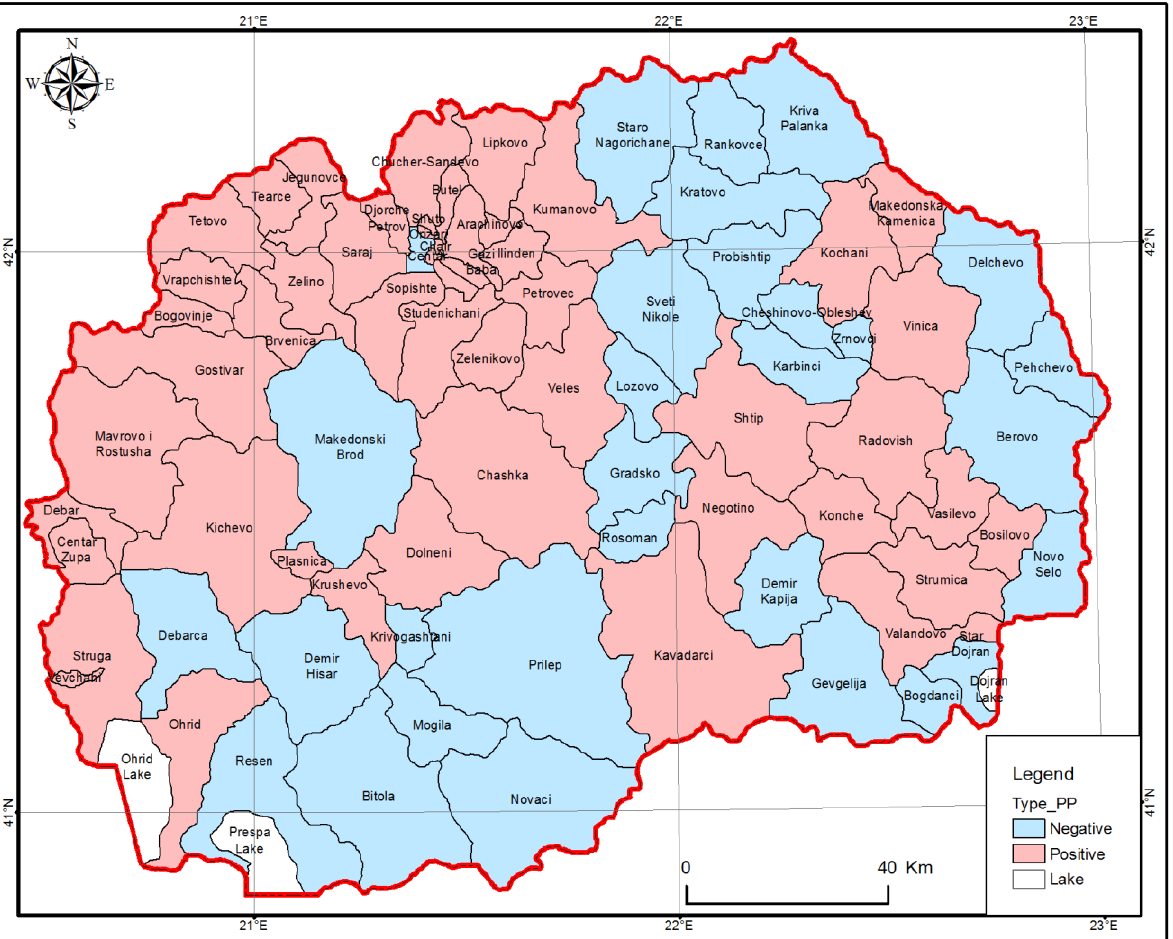
Fig. 7. Values of the population natural increase by municipalities, for the period 2002-2013 (calculated by the authors, according to SSORM, map author,